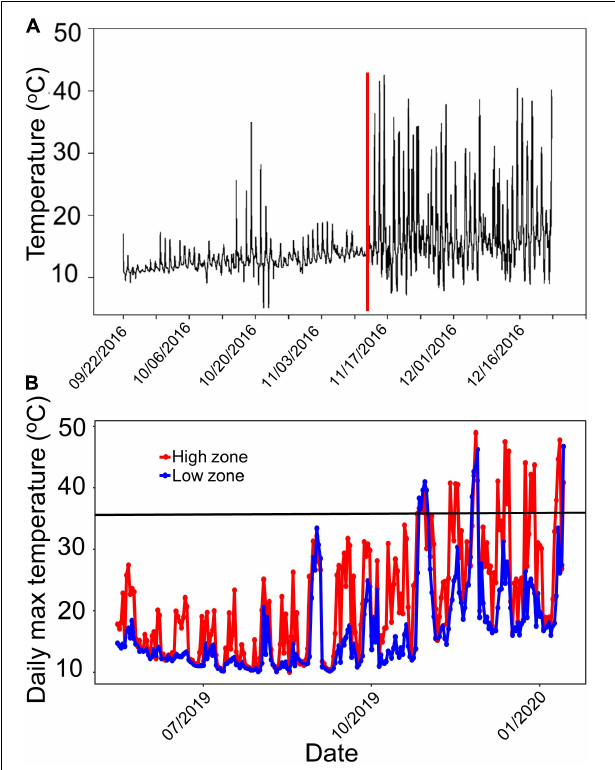
FIGURE 2 | (A) Temperatures within the mid-tide Hormosira zone of Wairepo Reef, Kaikoura, before, during and after the earthquake on 14 November 2016; vertical line indicates timing of the earthquake. (B) Maximum daily temperatures for the upper mid (red) and lower mid tidal zones at Wairepo Reef, Kaikoura from 2018 to 2019. Inset line indicates approximate lethal temperature for fucoid algae exposed for c 4 h at low tide. a compromised light environment below the depth threshold.